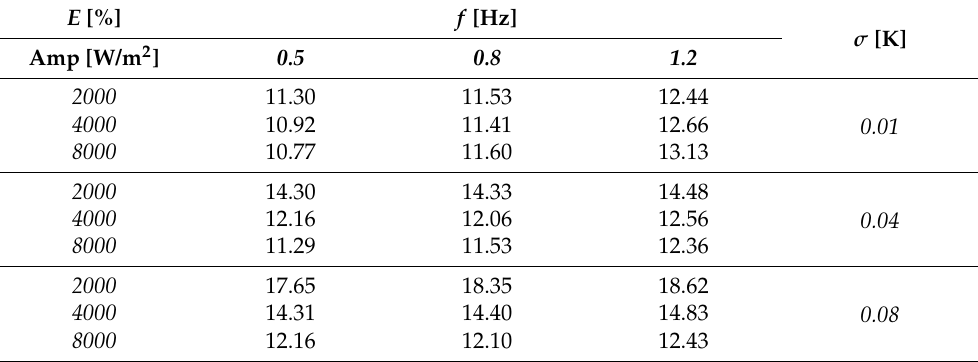
Table 3. Restoration error E as a function of noise level σ , for different amplitudes of q exact and frequencies f